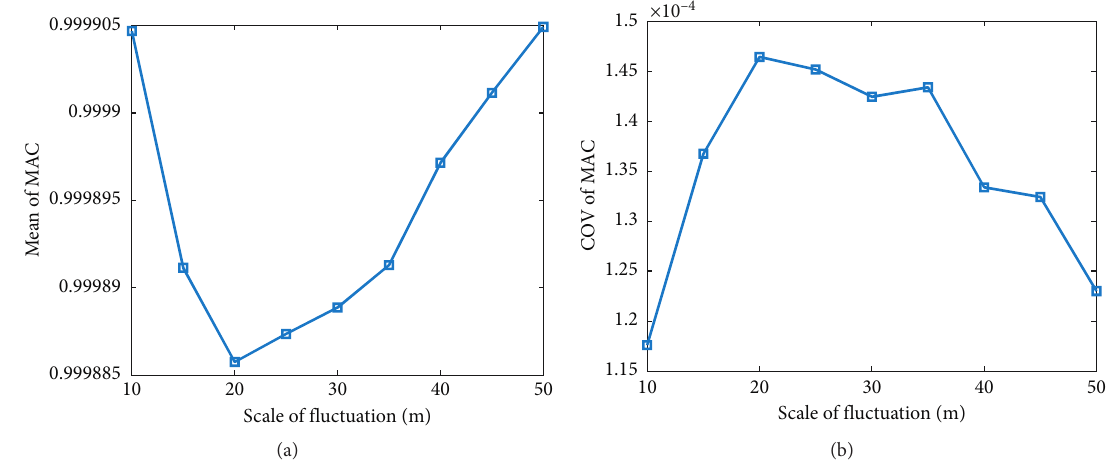
Figure 16: Statistics of the first-order MAC values for different scales of fluctuation: (a) mean and (b) COV. The mesh size is 4 times the reference